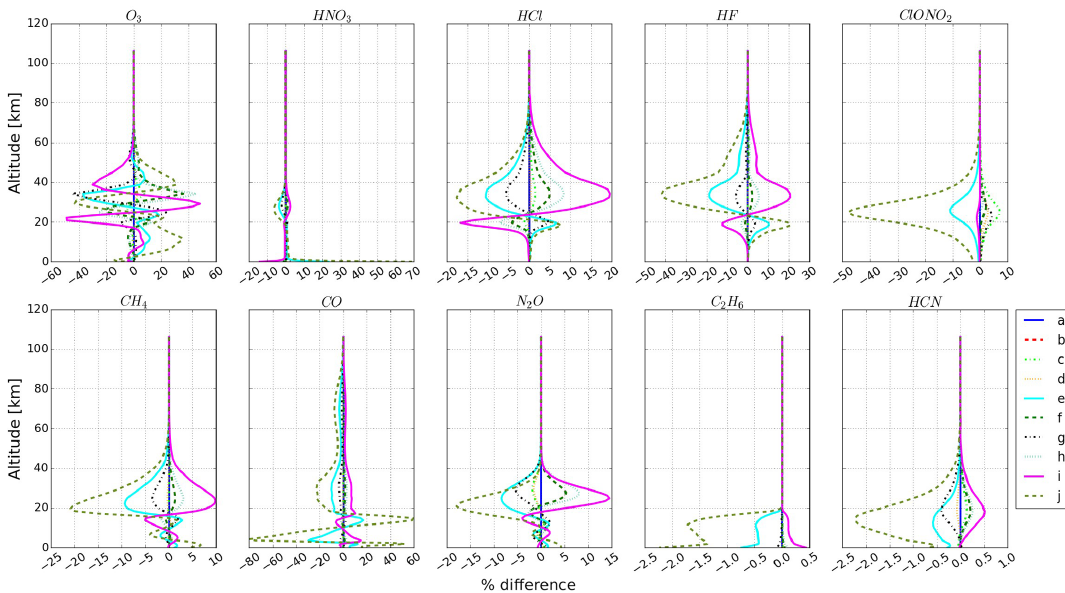
Figure 9. Sensitivity of the profile to different types of ILS degradation. The ILSs a to j correspond to misalignment a to j in Table 1. The results are deduced from the spectra recorded at Hefei on 16 February